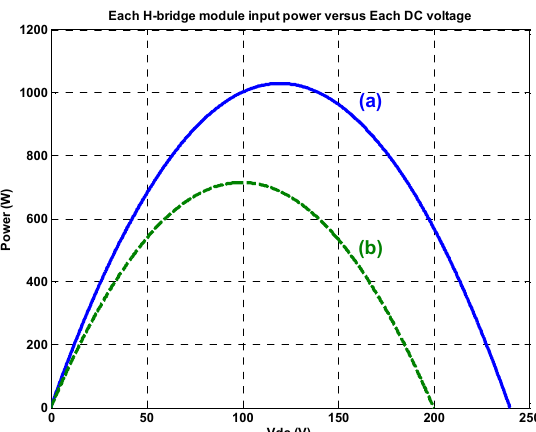
Figure 8. Each input power versus each DC voltage characteristics. ( a ) emulated PV system with the maximum 1 kW at 240 V DC voltage, ( b ) emulated PV system with the maximum 714 W at 200 V DC voltage.